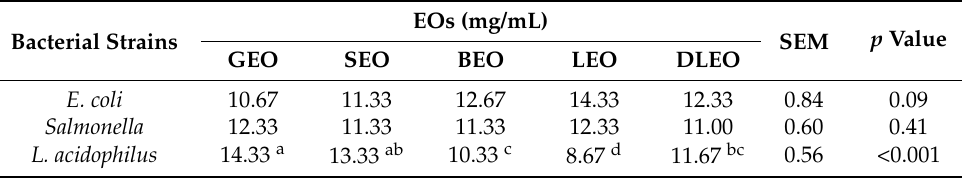
Table 3. Inhibition zone diameter (IZD, mm) of citrus EOs. Bacterial Strains